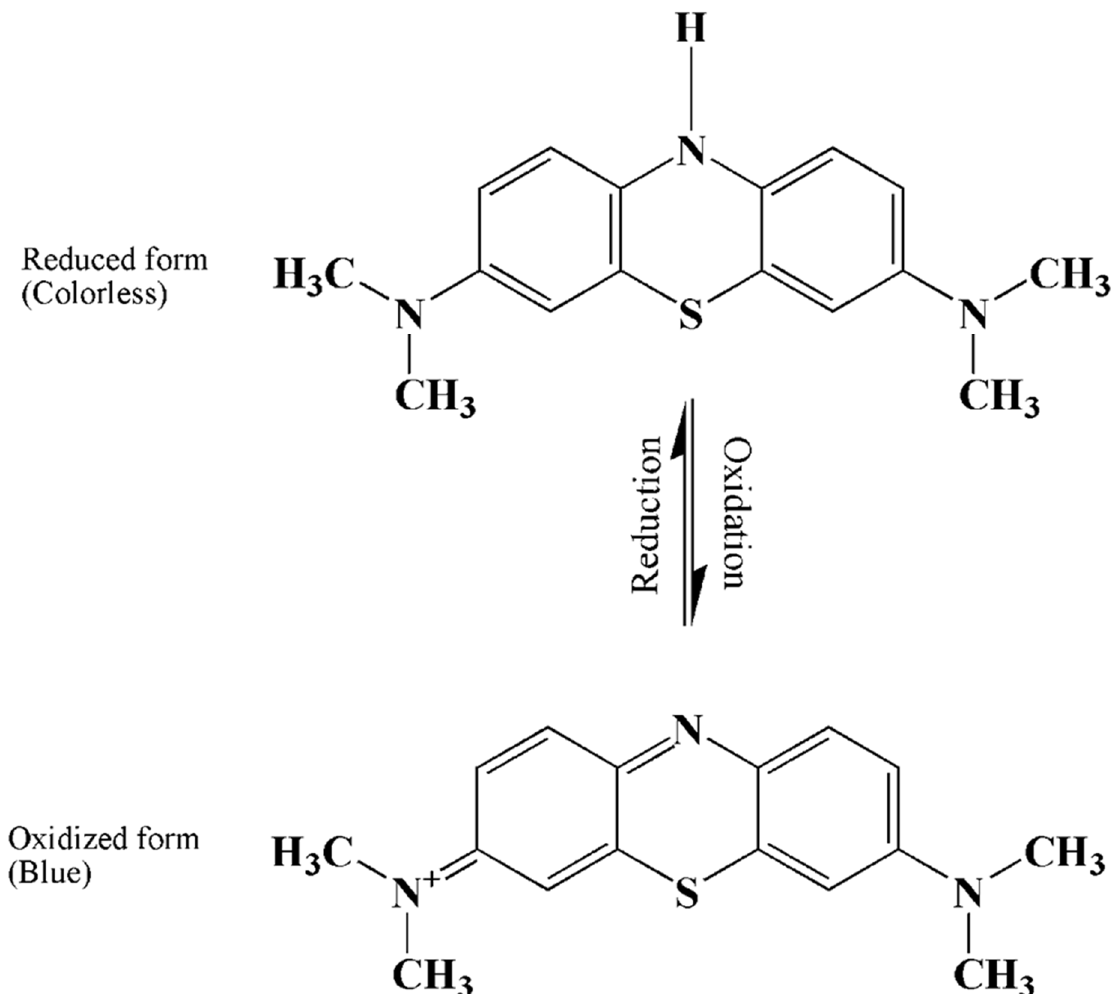
Figure 4. Oxidized and reduced forms of MB.